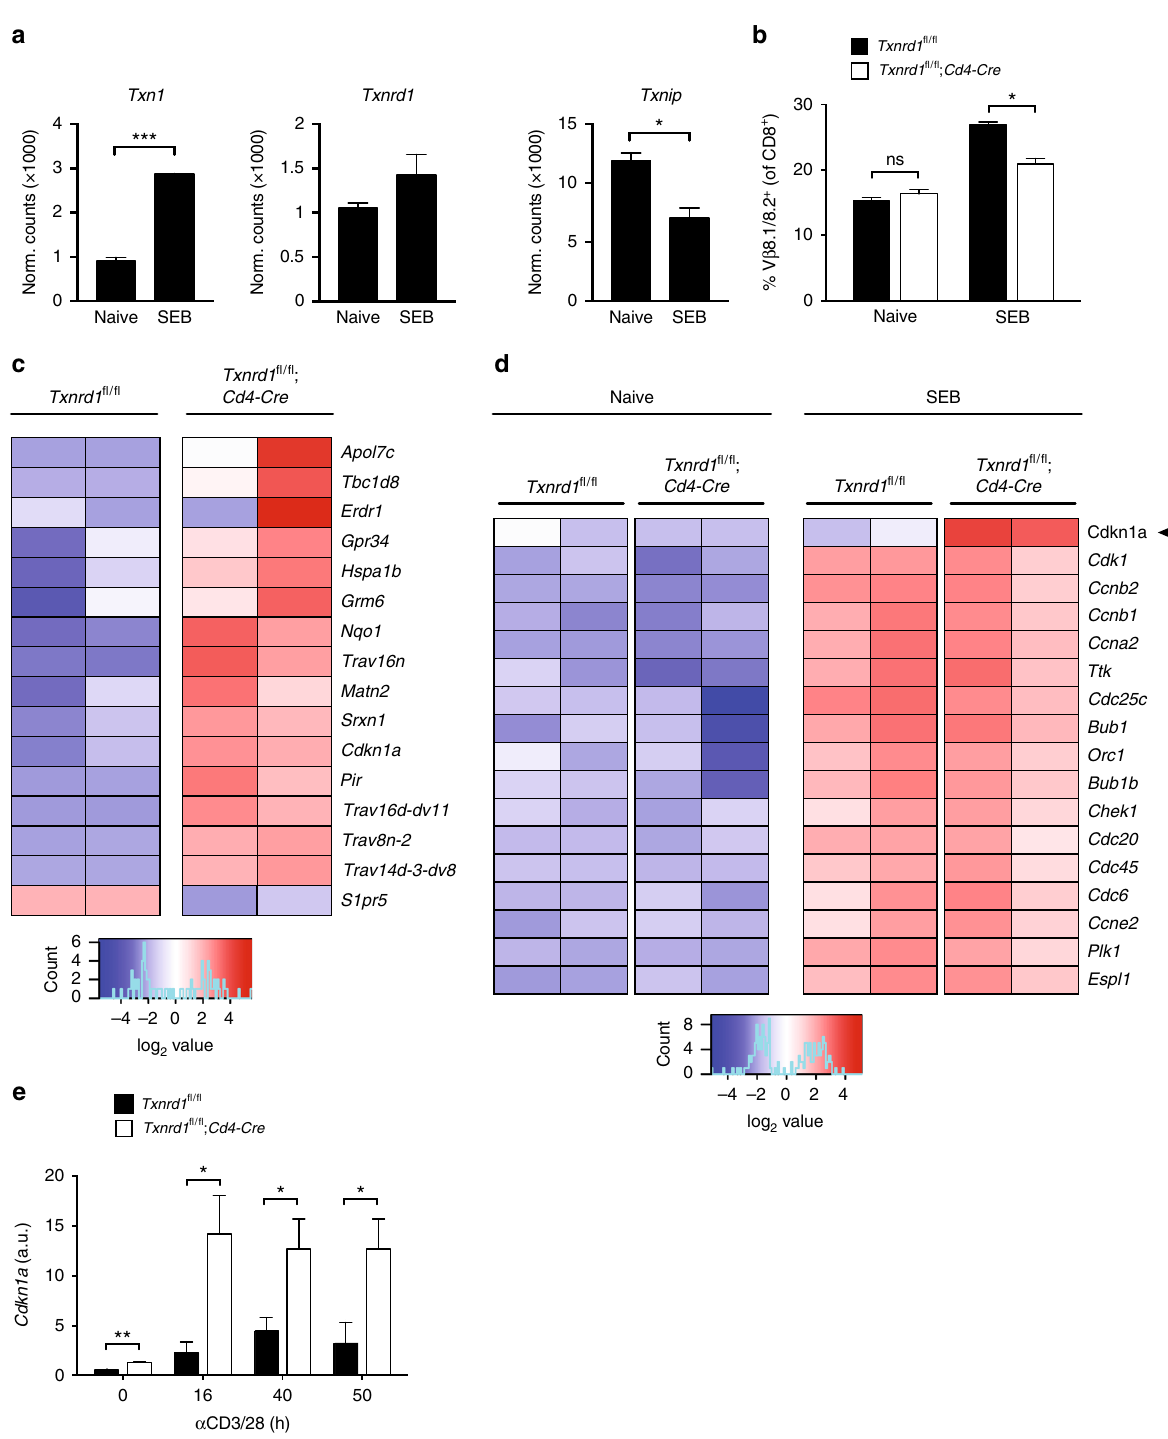
Fig. 6 Txnrd1 de fi ciency increases expression of the cell cycle inhibitor Cdkn1a . a – d Txnrd1 fl / fl and Txnrd1 fl / fl ; Cd4-Cre mice were treated i.p. with 100 μ g of Staphylococcal enterotoxin B (SEB) or PBS. V β 8.1/V β 8.2 + CD8 + T cells were FACS sorted at day 2, and gene expression pro fi les determined by RNA-seq (two biological replicates per group). a Expression of Txn1 , Txnrd1 , and Txnip in V β 8.1/V8.2 + CD8 + T cells from WT mice after PBS (naive) and SEB treatment. b Percentages of V β 8.1/V β 8.2 + cells among CD8 + T cell population are shown. c Heat map showing expression changes between SEB- stimulated Txnrd1 -de fi cient and control T cell groups (|GFOLD| > 1.5; FDR < 0.2). d Heat map indicating the top differentially expressed genes involved in the cell cycle. Only genes with a |GFOLD| larger than 1.5 between naive and stimulated groups are displayed. e Magnetically sorted T cells from spleen and peripheral LNs of naive Txnrd1 fl / fl and Txnrd1 fl / fl ; Cd4-Cre mice were stimulated in α CD3/CD28-coated plates. Cdkn1a expression was assessed using RT- PCR at the indicated times ( n = 2 – 3). Bar graphs show mean + standard deviation ( a , b , e ). Data are representative of one ( a , c , d ) and two ( b , e ) independent experiments. Student ’ s t test (two-tailed, unpaired) was used to compare Txnrd1 fl / fl and Txnrd1 fl / fl ; Cd4-Cre groups ( a , b , e ): * P ≤ 0.05; ** P ≤ 0.01; *** P ≤ 0.001; ns not signi fi